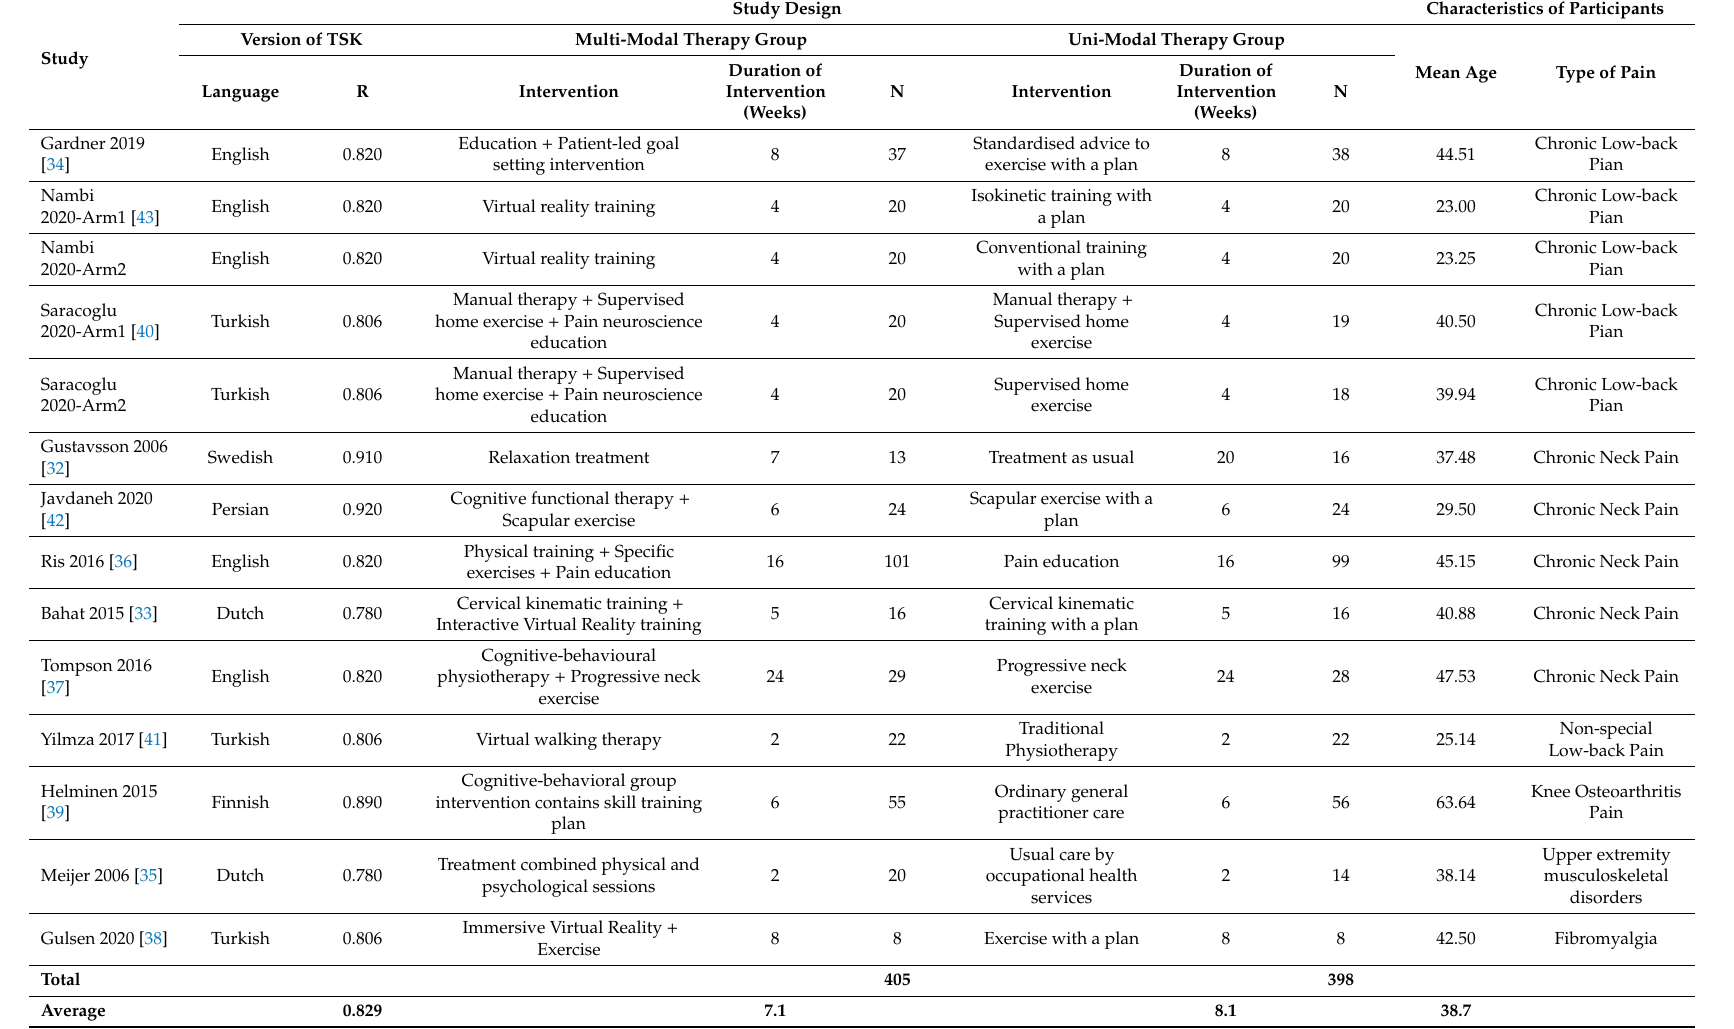
Table 1. The result of data